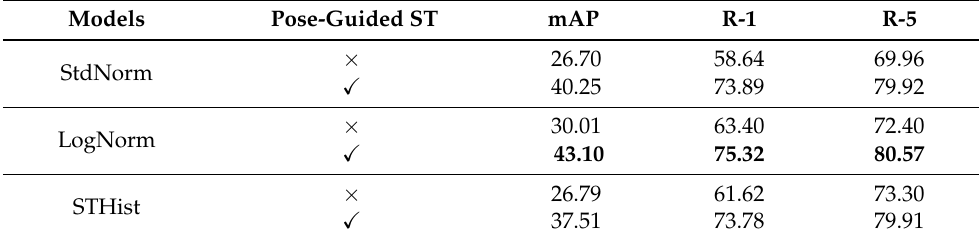
Figure 11. CMC results of comparisons of spatio-temporal model on the VeRi-776 dataset. Table 7. Comparisons (%) of the performance of spatio-temporal model on the VeRi-776 dataset. The best results are shown in bold.